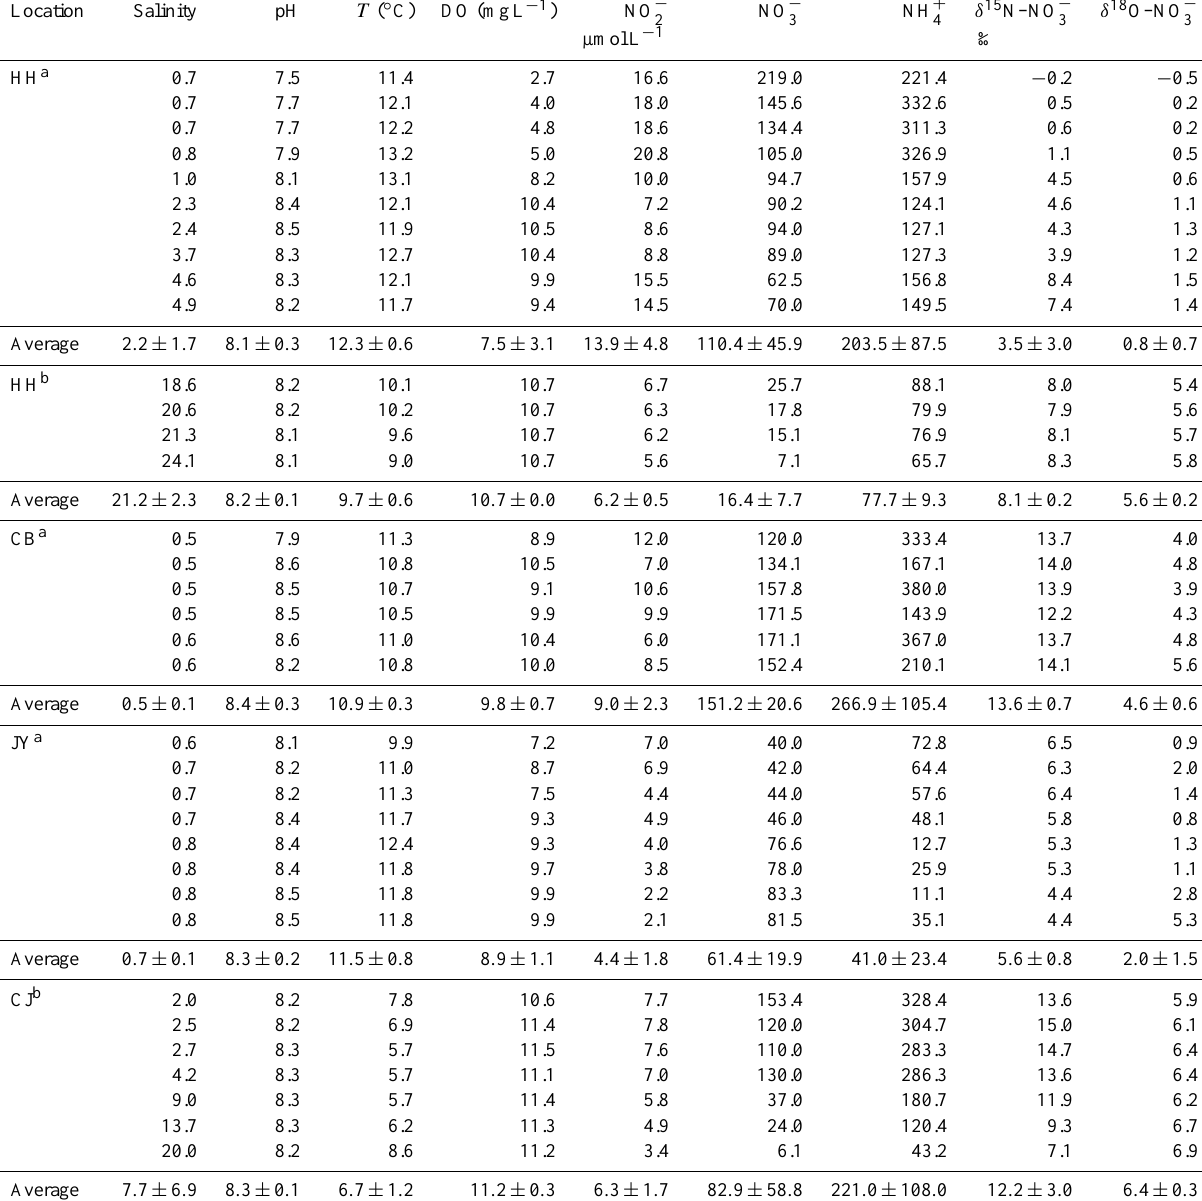
for the three investigated rivers and the corresponding estuaries. 3